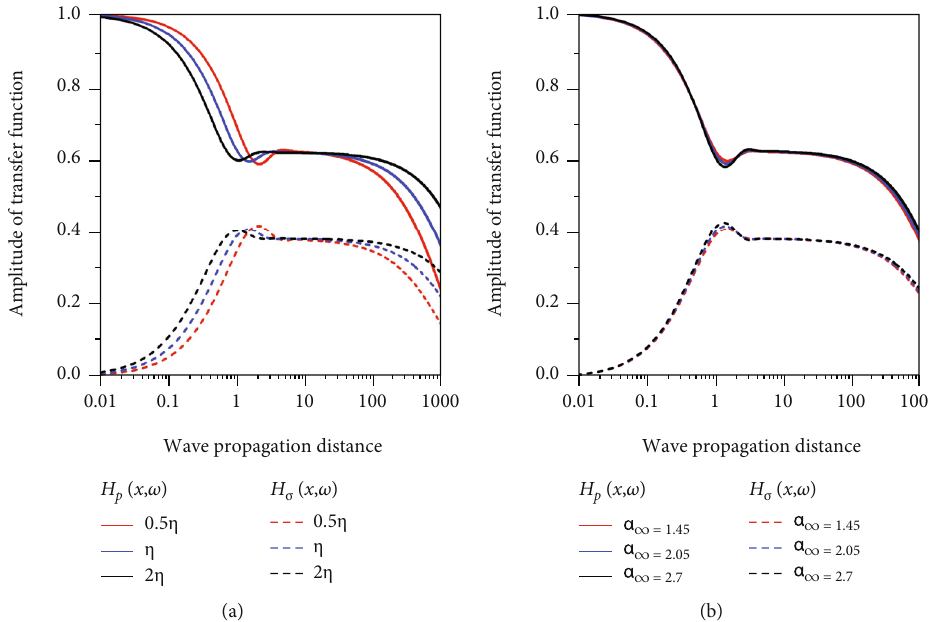
Figure 6: Normalized amplitude of pore pressure and stress versus wave travelling distance based on Darcy-Brinkman law with η as a parameter (a) and with added-mass coe ffi cient α ∞ as a parameter (b) at an angular frequency of 1000 Hz. The solid line denotes the transfer function of the pore pressure, and the dash-dot line represents the transfer function of the stress. The wave travelling distance is p ffiffiffiffiffiffiffiffiffiffiffiffiffiffi at frequency of 2 × 10 − 6 Hz normalized by the viscous penetration length δ = 2 μ / ωρ l